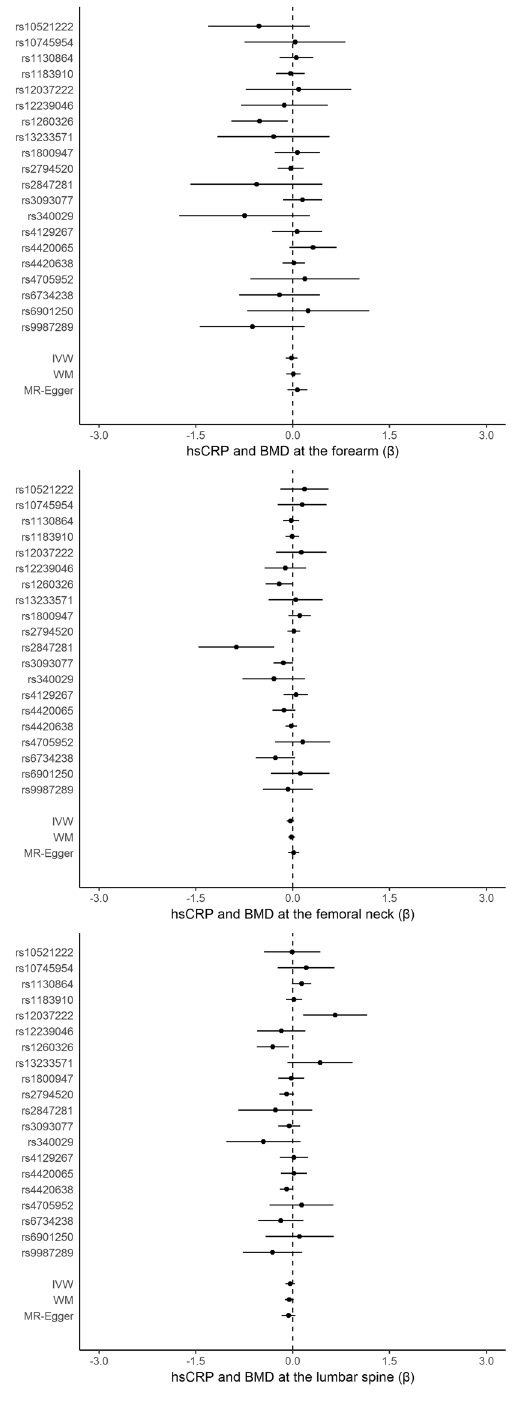
Figure 1. SNP-specific associations of hsCRP (Prins et al .) with bone mineral density (BMD) at each skeletal